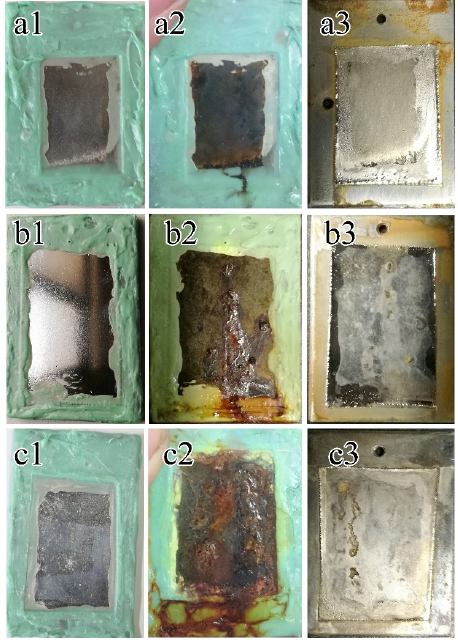
Figure 9. Corrosion results of samples deposited under DP. ( a1 ) as deposited; ( a2 ) as deposited after 1000 h test; ( a3 ) as deposited with corrosion product removed; ( b1 ) 300 °C treated; ( b2 ) 300 °C treated after 1000 h test; ( b3 ) 300 °C treated with corrosion product removed; ( c1 ) 400 °C treated; ( c2 ) 400 °C treated after 1000 h test; ( c3 ) 400 °C treated with corrosion product removed.